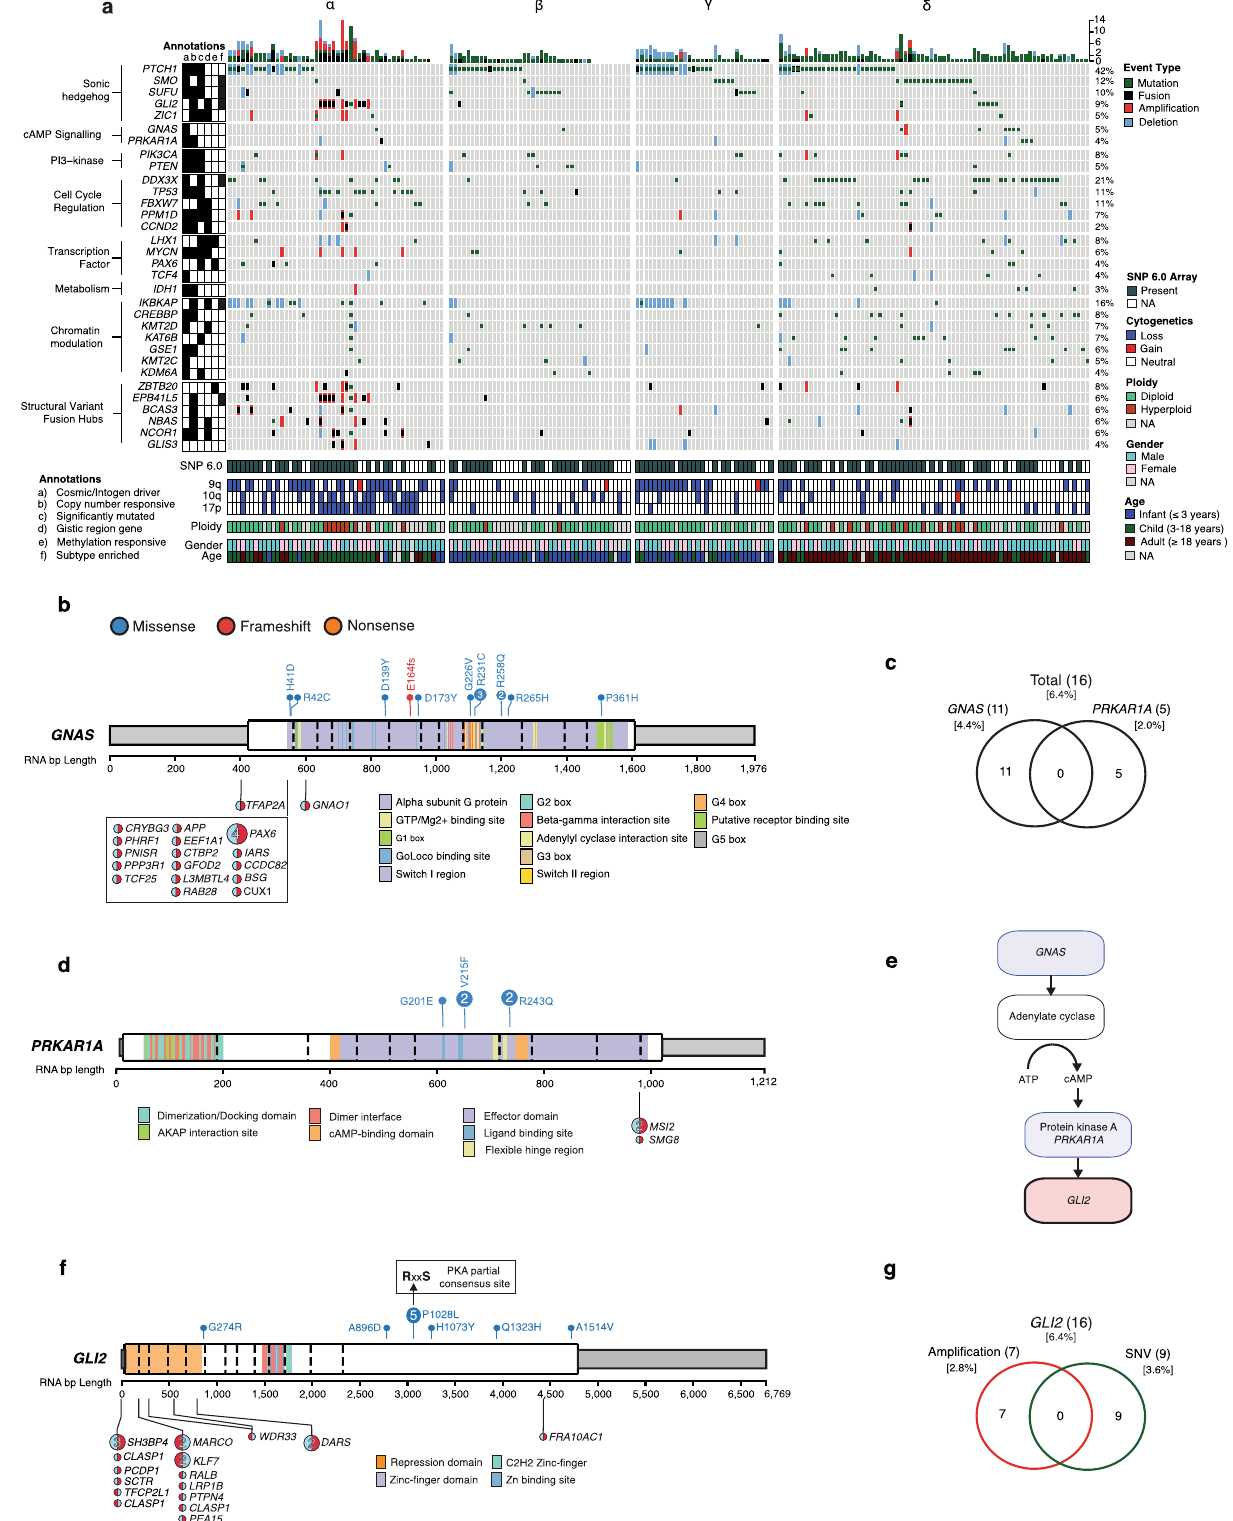
Fig. 2 cAMP-dependent pathway alterations converge on GLI2 activity. a Oncoprint summaries of all fusion, mutation, and copy number data ( n = 196). Subtypes are denoted above. NA, not available. b Gene-level summary of GNAS events. c Mutual exclusivity of GNAS and PRKAR1A LOF events. LOF events include mutations and homozygous deletions. d Gene-level summary of PRKAR1A events. e cAMP dependant signaling pathway schematic. Red indicates activating alterations while blue indicates inactivating alterations. f , g Gene-level summary of ( f ) GLI2 events and ( g ) their overlaps. Mutations in f are shown as lollipop diagrams above the gene schematic and fusion events are shown below. The 5 prime and 3 prime orientation of the fusion transcript is indicated by the color orientation. In cases where GLI2 is the 3 prime partners, the fusion lollipop is red on the right.